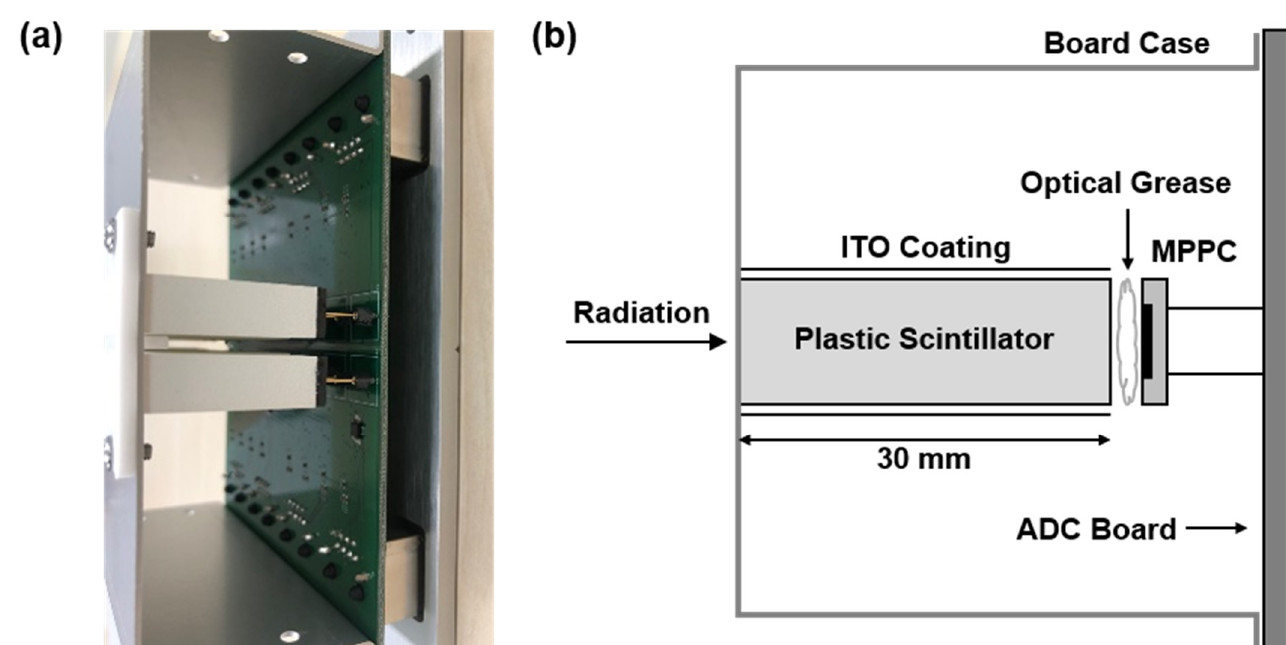
Figure 4. Neutron detector module: ( a ) side view of the neutron detector module, ( b ) block diagram of the neutron detector module. The plastic scintillator for the thickness of 30 mm renders high- energy radiations visible, the multi-pixel photon counter (MPPC) generates electrical pulses, and the analog-to-digital (ADC) board sends a signal to the DAQ system.